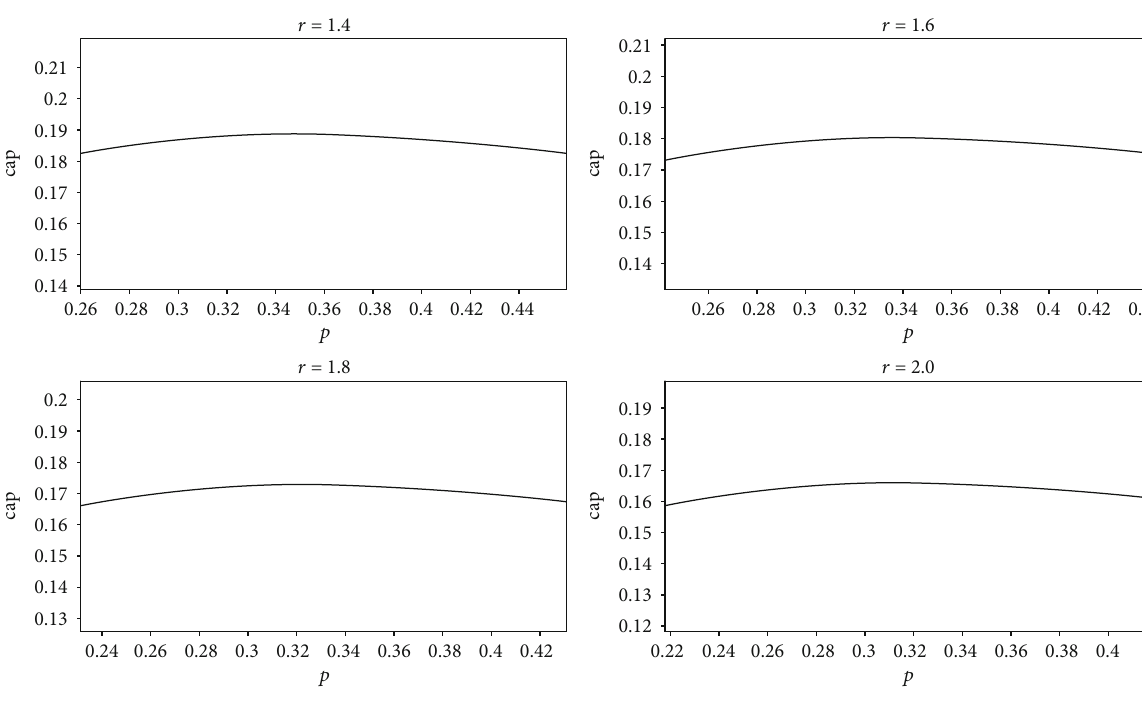
Figure 11: The relationship between cap and p